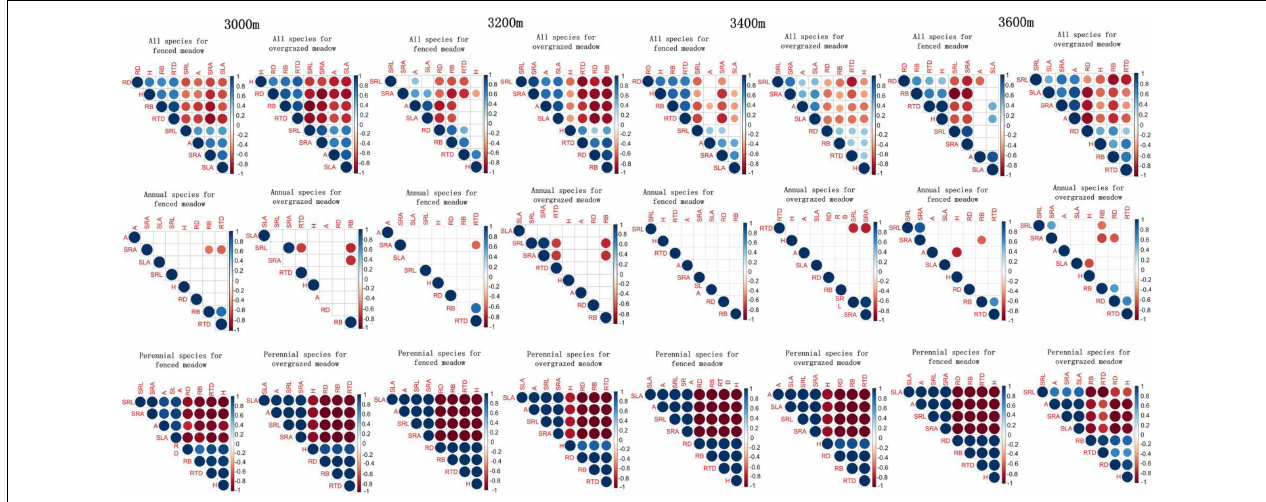
FIGURE 3 | The interrelationships among above-ground traits (H, A, and SLA) and below-ground traits (RD, RB, SRL, SRA, and RTD) in fenced and overgrazed meadows for all species (upper panel), and separately for annuals (middle panel) and perennial species (lower panel) from 3000 to 3600 m elevations.